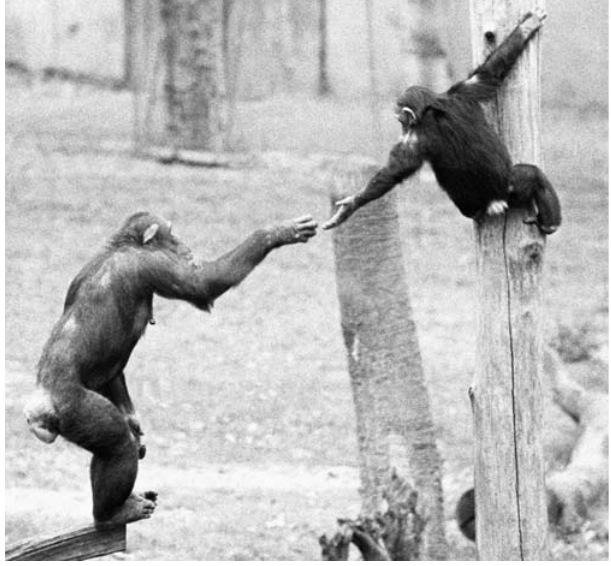
Figure 1. Apes Often Show So-Called “Targeted Helping,” Which Is Aid Tailored to the Other’s Specifi c Needs In this case, a mother chimpanzee reaches out to help her juvenile son out of a tree after he screamed and begged (see hand gesture). (Photograph by F.B.M. de